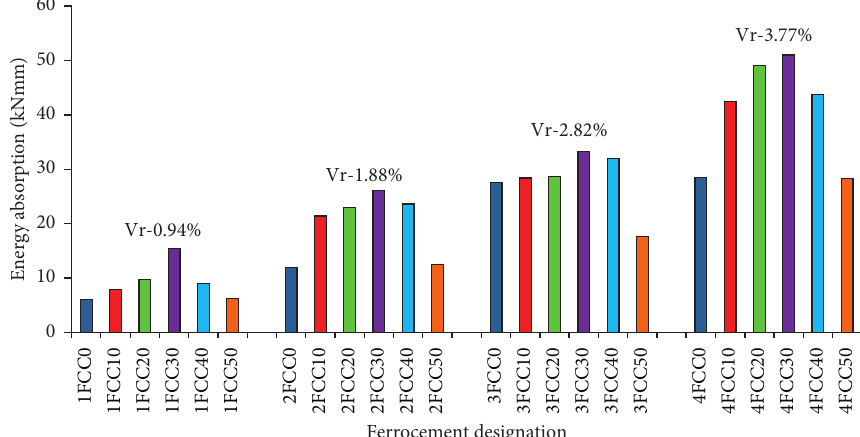
Figure 9: Energy absorption for different levels of steel slag replacement and volume fractions of chicken mesh ferrocement laminates.